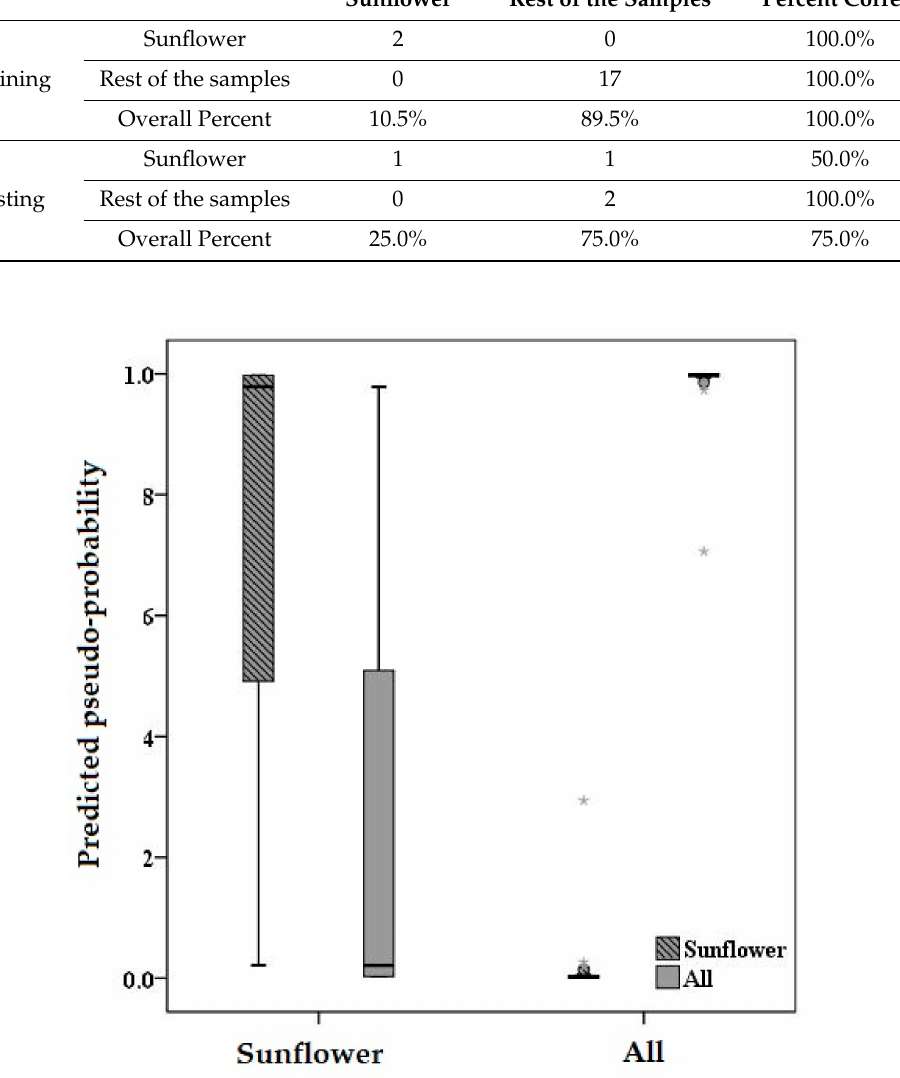
Figure 5. Box plot of pseudo probabilities obtained using a multilayer perceptron-artificial neural network (MLP-ANN) for the model that predicts oil